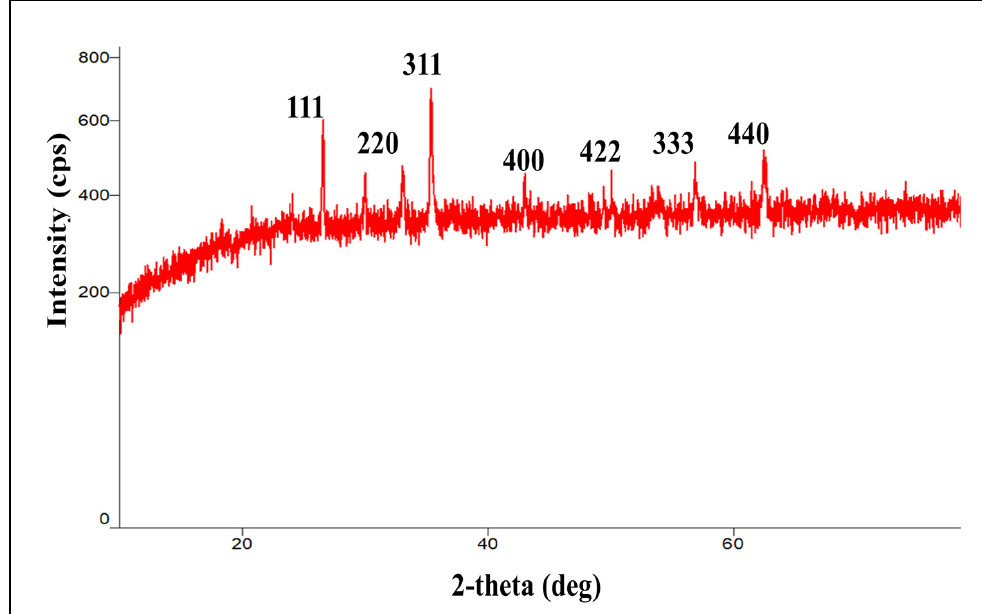
Figure 6. X-ray diffractogram of SPIONs.